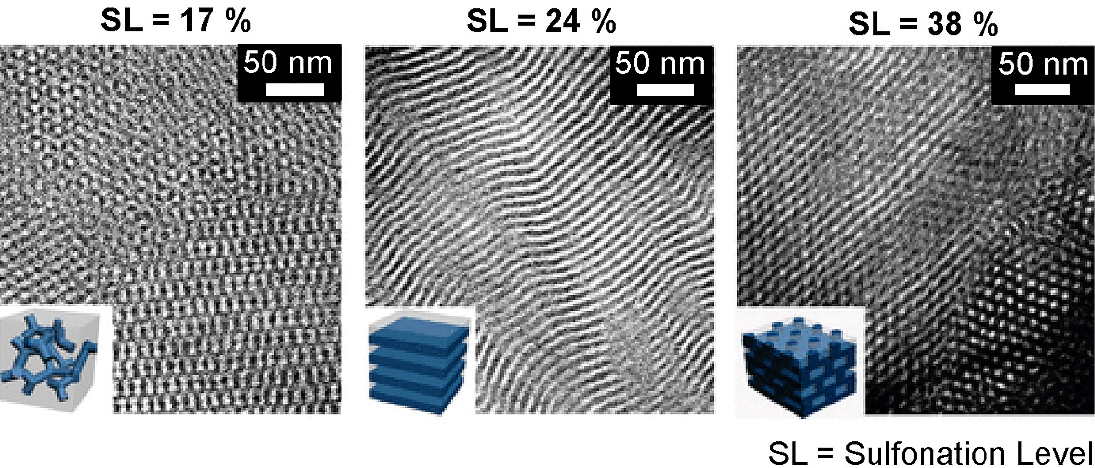
Figure 3. Phase behavior of poly(styrenesulfonate-methylbutylene) (PSS-PMB) block copolymers. Evolution of the morphological changes upon increasing sulfonation level from 17 to 38%. Reprinted with permission from reference [120]. Copyright 2008, American Chemical Society.